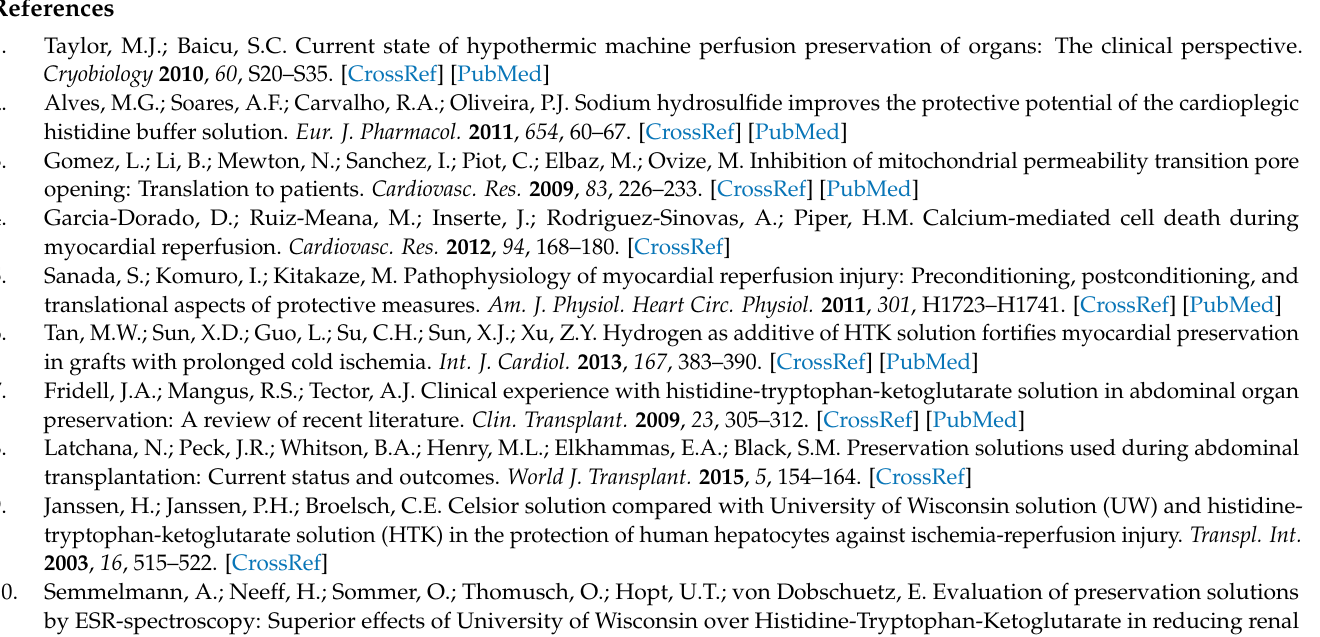
Figure S3: The dose-dependent NBC activity of oh8dG-treated A549